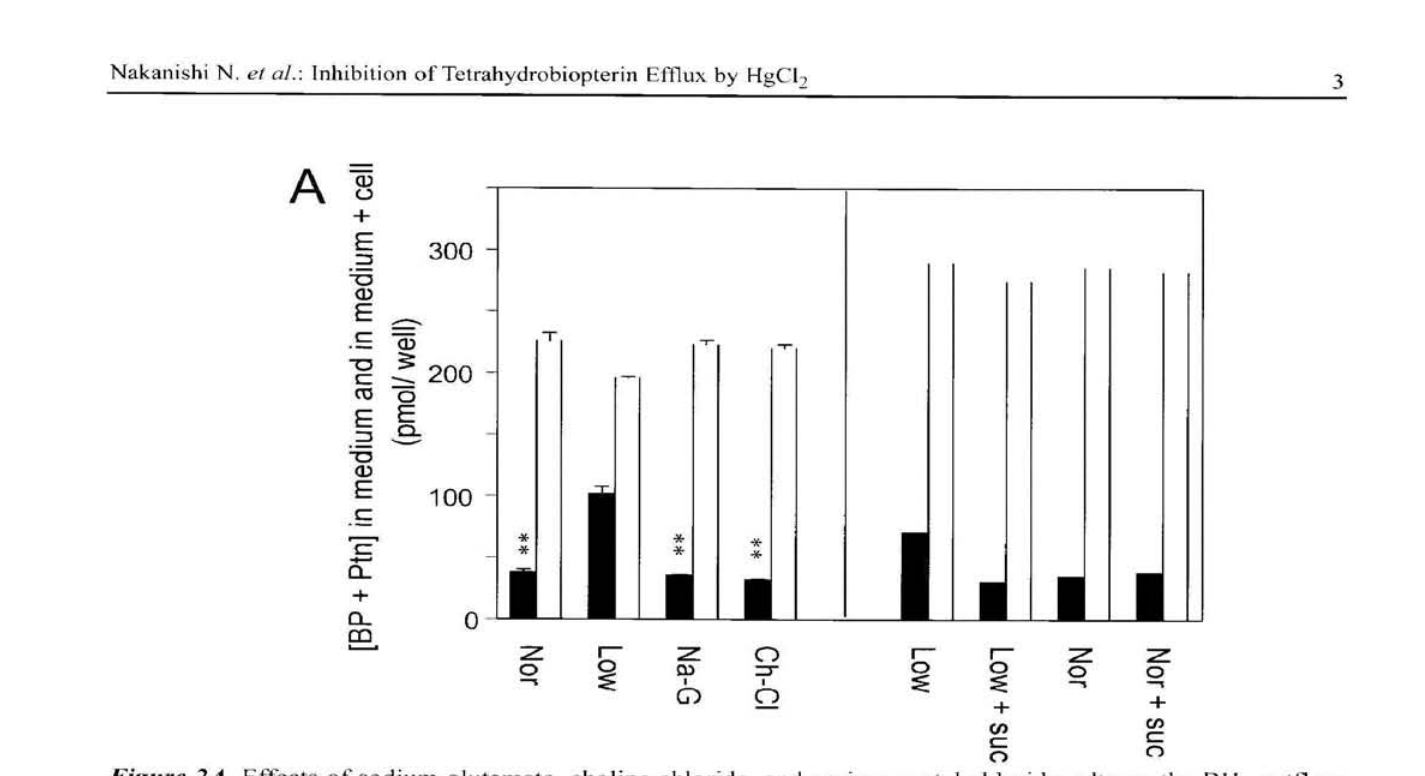
Figure 2A. Effects of sodium glutamate, choline chloride, and various metal chloride salts on the BH 4 outflow from PC 12 cells, (closed bar: [BP+Ptn in medium, open bar: sum amount of medium [BP+Ptn] plus cell [BP+Ptn]). In the left side panel, PC 12 cells in a 12-well plate were incubated in normal Hanks medium (Nor, 138mM NaCl) and low-NaCl Hanks medium (Low; 20 mM NaCl) in the presence and absence of 0.14 M sodi- um glutamate (Na-G) or 0.14 M choline chloride (Ch-Cl). Values are the means ± SD (n=3). **p<0.001 vs. the value obtained with low NaCl Hanks medium (Low). In the right side panel, cells were incubated with normal and hypotonic Hanks medium (30 mM NaCl) in the presence and absence of sucrose (0.25 M) for 10 min in a C 0 2 incubator at 37°C. Values are the means of duplicate experiments.